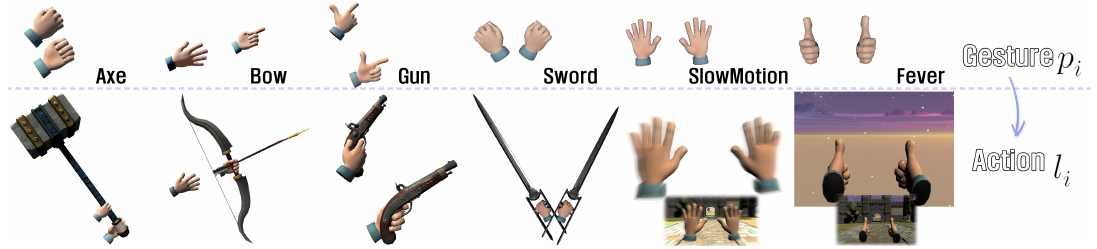
Figure 5. Immersive interaction process of directly reflecting corresponding gestures to the actions in the virtual